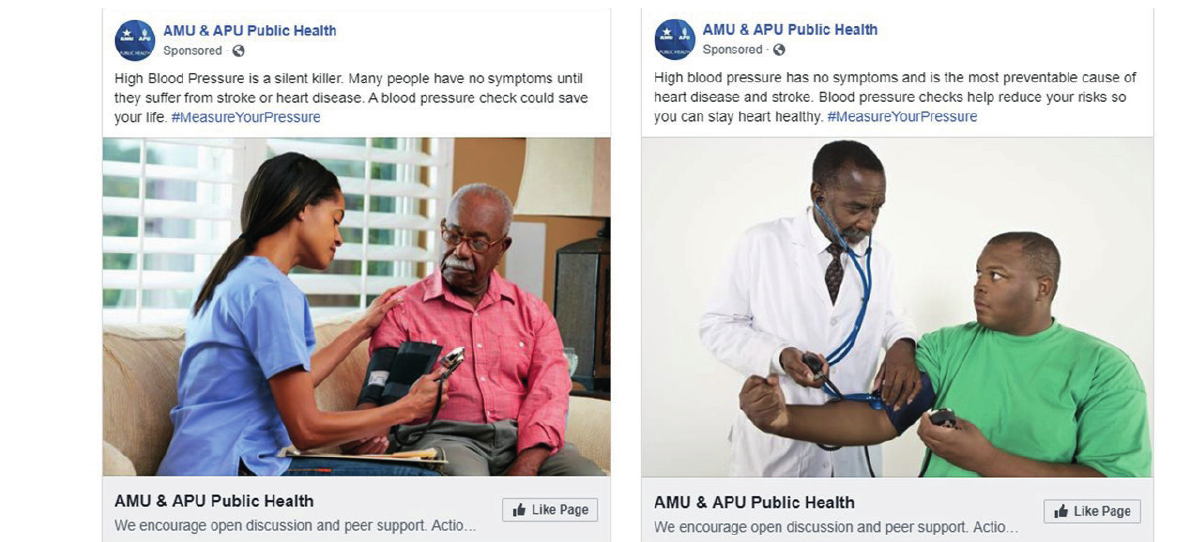
Figure 2. Facebook ads-Like page, (Measure Your Pressure) MYP 1-General and MYP 1-AA (left), and MYP 2-Ge- neral and MYP 2-AA